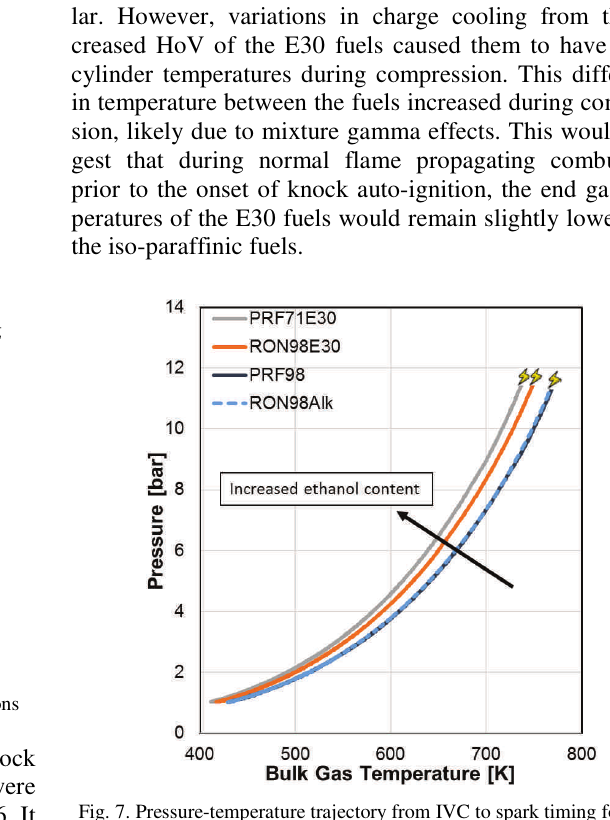
Fig. 7. Pressure-temperature trajectory from IVC to spark timing for each fuel at RON rating